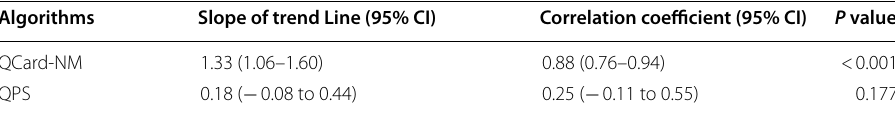
Table 4 Results of linear regression analysis of the calculated RV cavity volume in the QCard-NM and QPS algorithms using XCAT